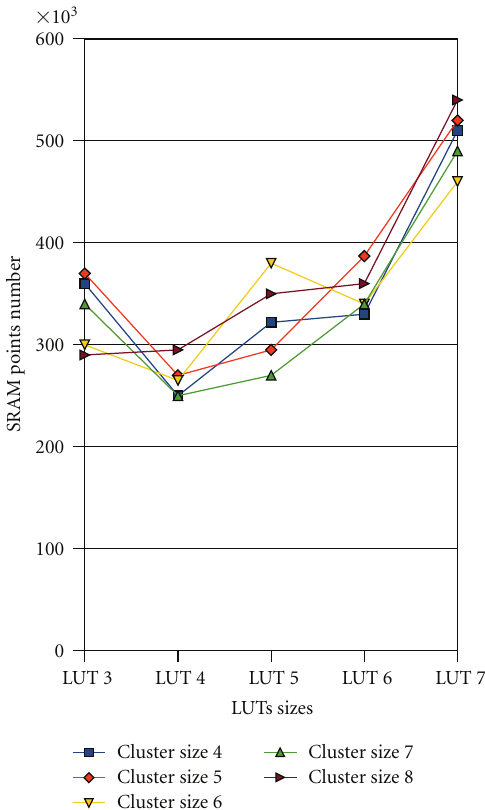
Figure 12: SRAM cells number clusters sizes 4–8 (21 benchmark average)